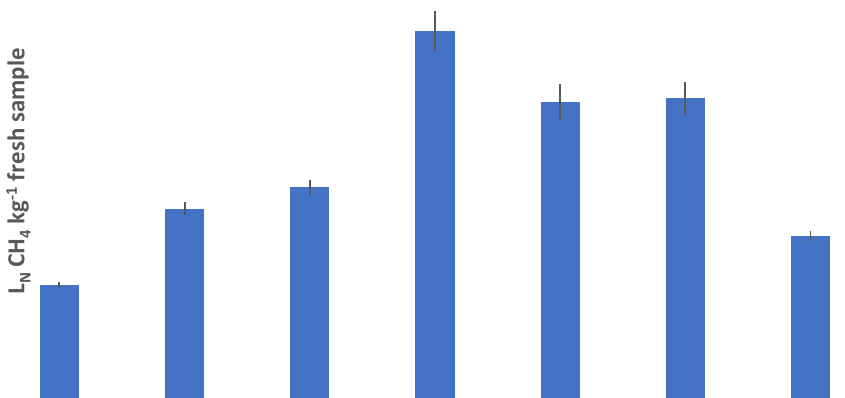
Figure 2. Total specific methane production of by-products from the alcoholic beverage production in L N CH 4 kg − 1 fresh sample from the BMP tests (SD for each substrate: PA, 0.7; T, 1.7; GSW, 1.9; GSB, 5.1; BSG, 4.6; GM, 4.2; EGM, 1.5).